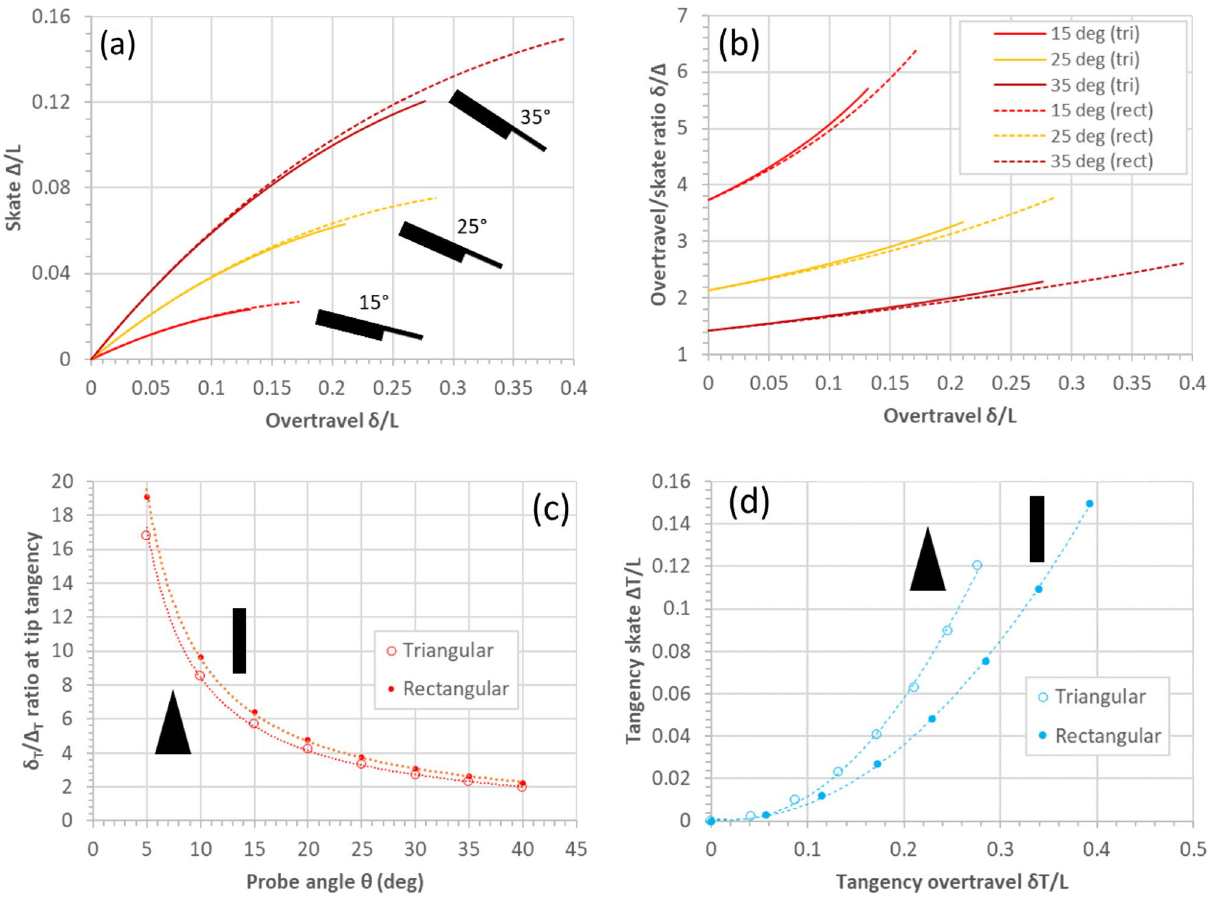
Figure 15. Comparison of skate and overtravel between a triangular cantilever and a rectangular cantilever. ( a ) The skate versus overtravel for triangular (solid curves) and rectangular (dashed curves) cantilevers. ( a ) The overtravel/skate ratio versus overtravel for triangular (solid curves) and rectangular (dashed curves) cantilevers. The tangency overtravel/skate ratio versus the cantilever tilt angle for triangular (open circles) and rectangular (filled circles) cantilevers. The tangency skate versus the tangency overtravel for triangular (open circles) and rectangular (filled circles) cantilevers. All graphs (solid or dashed) correspond to the modelling.